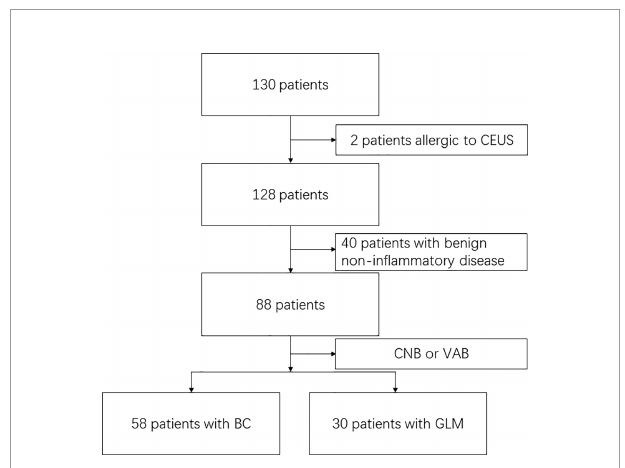
Table 1 . Patients with GLM were signi fi cantly younger (mean